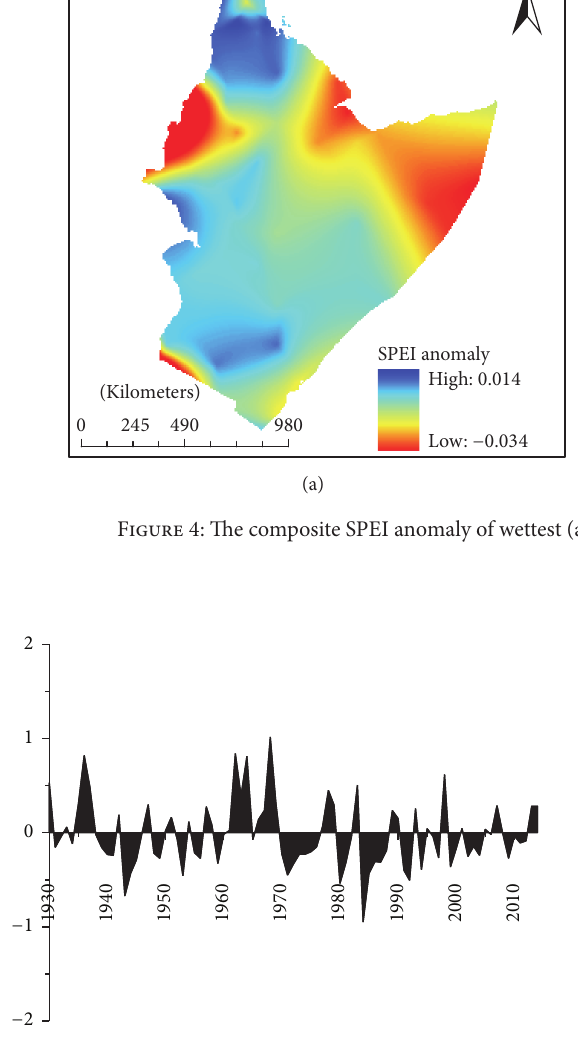
activities as land degradation [69] including deforestation, desertification, erosion, and overcultivation extremely high in the